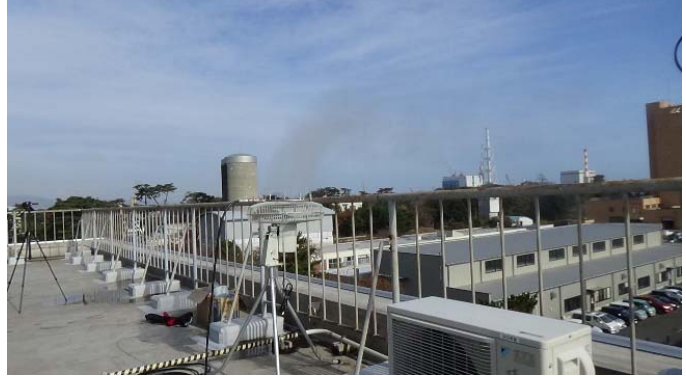
Figure 3. Photograph of the mist plume generated by the mist-spraying system.